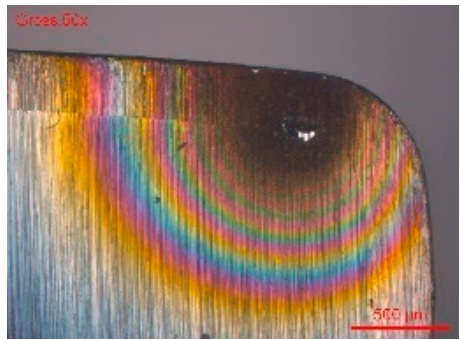
Figure 23. Corrosion of the transverse surface, at the level of the gold-steel interface.